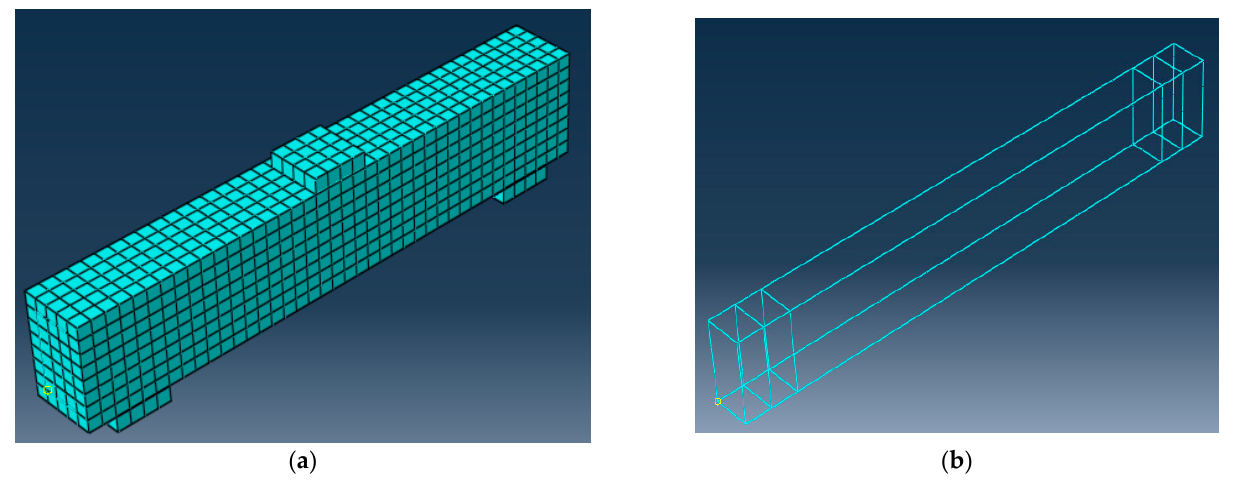
Figure 8. Meshes of some tested beams. ( a ) Concrete volume meshes; ( b ) Reinforcement meshes.